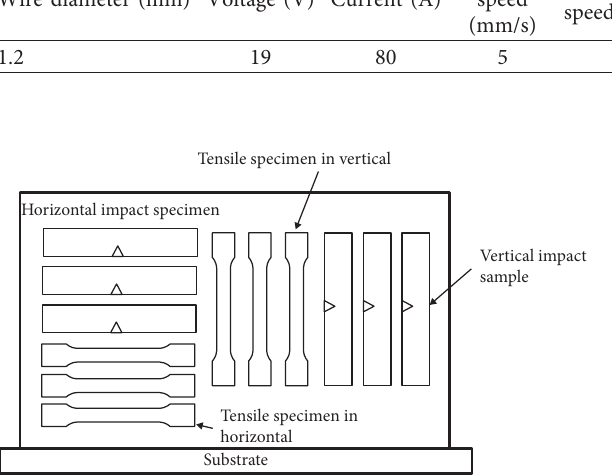
Figure 2: Diagram showing sampling points.